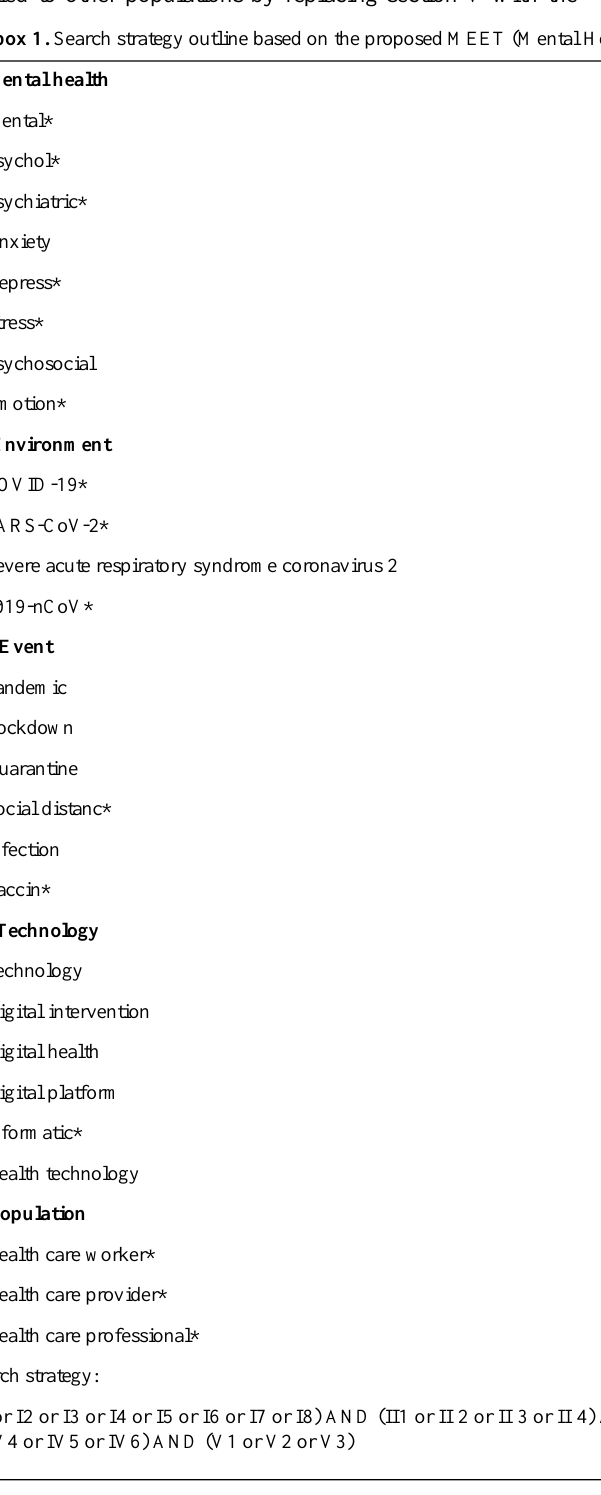
(title/abstract) using the keywords from the four